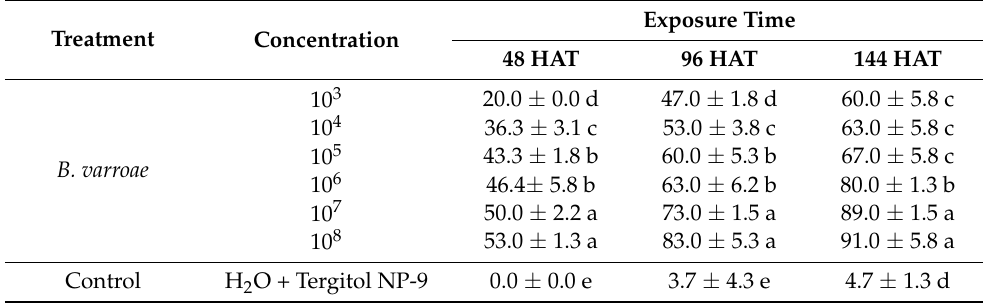
Table 1. Mean mortality ( ± SD) of T. pityocampa larvae. There is no significant difference between the means of the same column followed by the same letter (Tukey’s test, a = 0.05), HAT: Hours After Treatment.